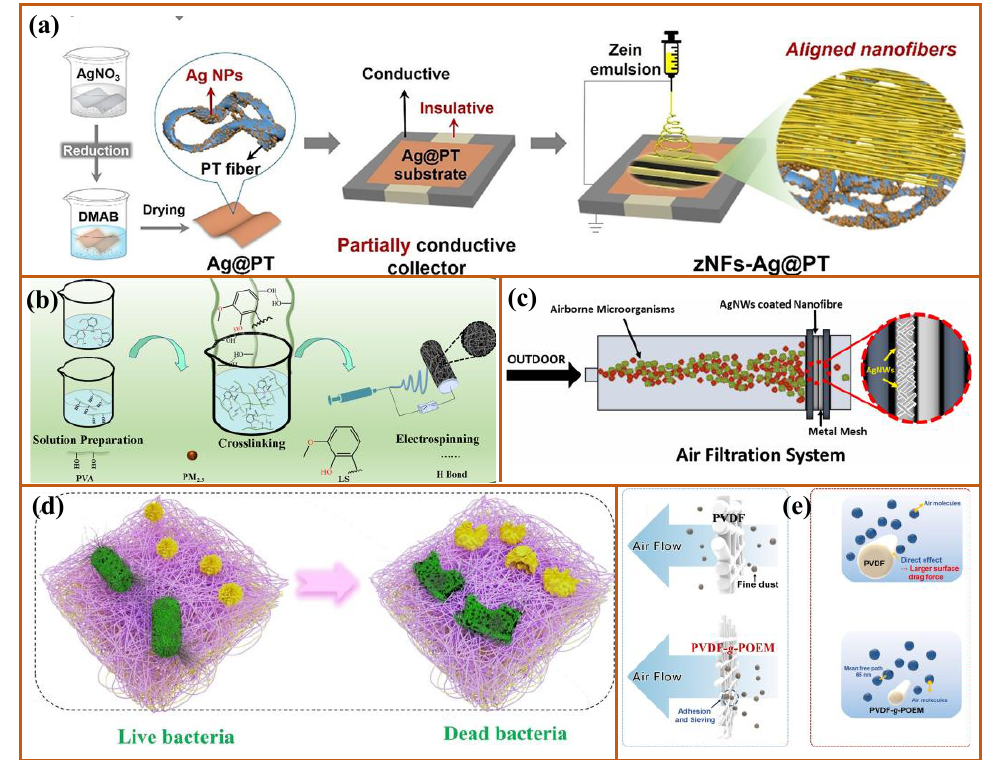
Figure 10. Multiprocess collaborative preparations: ( a ) preparation of Ag/PT substrate by in situ reduction method. Adapted with permission from [196]. Copyright, 2021 American Chemical Society; ( b ) preparation of composite nanofibers by green cross-linking method. Adapted with permission from [182]. Copyright, 2021 Elsevier; ( c ) two-step process of electrostatic spinning and electrospray. Adapted with permission from [197]. Copyright, 2021 Elsevier; ( d ) antibacterial fiber membrane. Adapted with permission from [198]. Copyright, 2020 Elsevier; ( e ) comparison of adsorption efficiency. Adapted with permission from [199]. Copyright, 2021